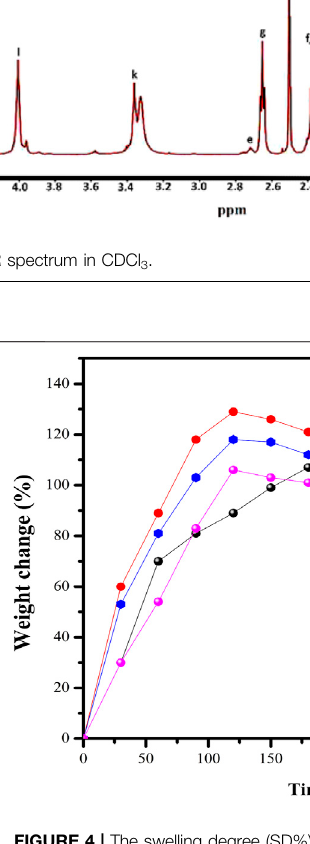
FIGURE 4 | The swelling degree (SD%) of the P β AE-447 in different